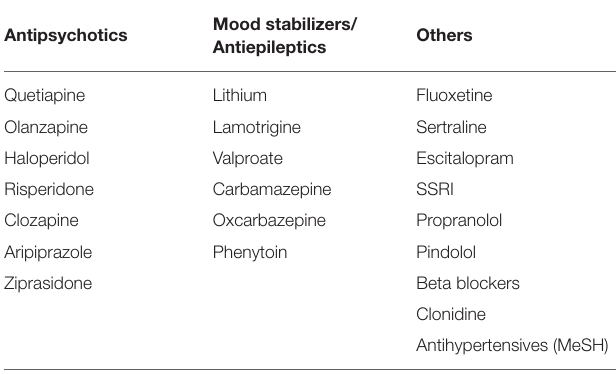
TABLE 2 | List of pharmaceutical agents searched for in the second literature review. Mood stabilizers/ Antipsychotics